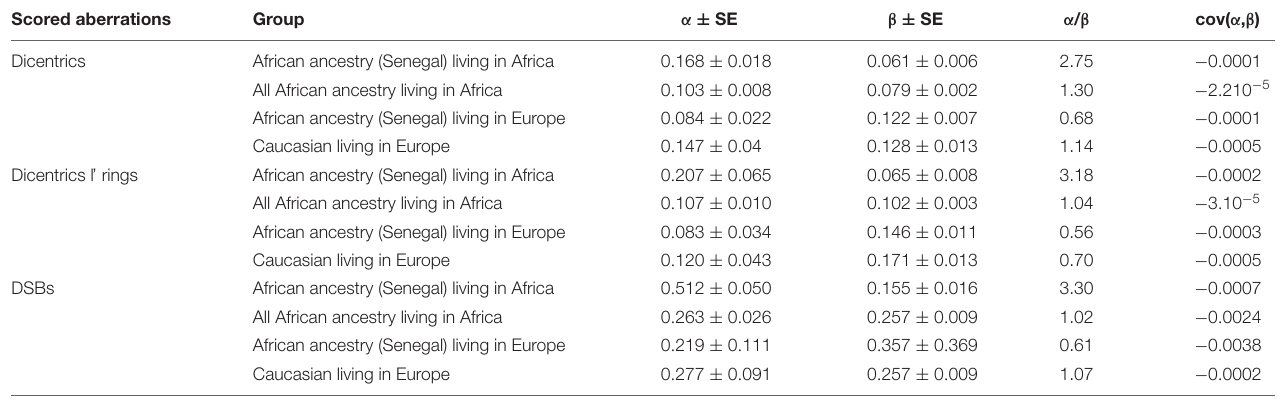
Standard errors and covariance α / β were shown.